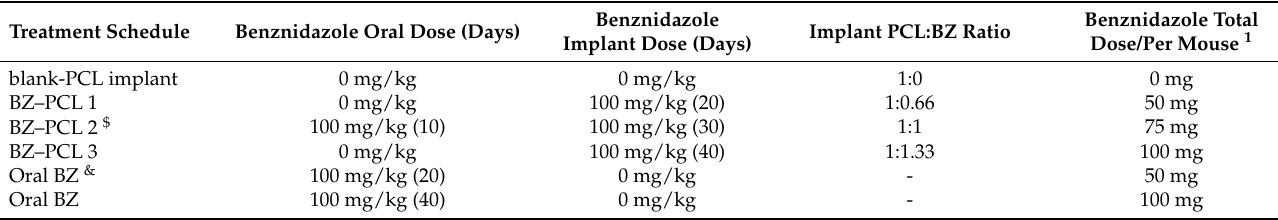
Table 1. Experimental groups and treatment